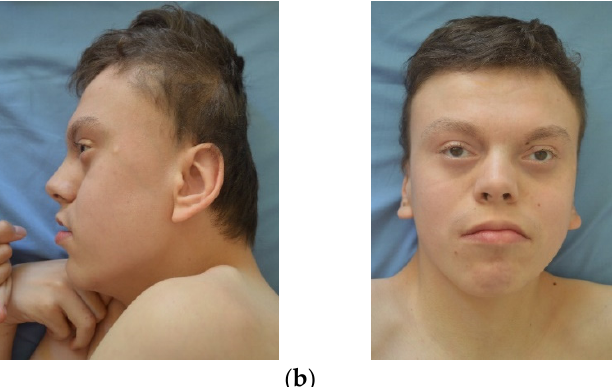
Figure 5. Karyotype for patient 2. 3.3. Case 3 The third patient is a girl aged 6 mo, the first child of healthy, unrelated parents, born at 36 weeks by C-section due to polyhydramnios, with a weight of 2840 g ( − 1.2 SD), length of 49 cm (0.0 SD), head circumference of 36 cm (+1.5 SD), Apgar score of 4/6/8, however with good postnatal adaptation. Physical examination revealed: normal growth, with a height of 67 cm (+1.0 SD), weight of 6200 g ( − 1.4 SD), HC of 43 cm (+0.9 SD); dysmorphic face (prominent forehead, frontotemporal baldness, sparse eyebrows, hypertelorism, down slanting palpebral fissures, ptosis, epicanthal folds, broad nasal bridge, long